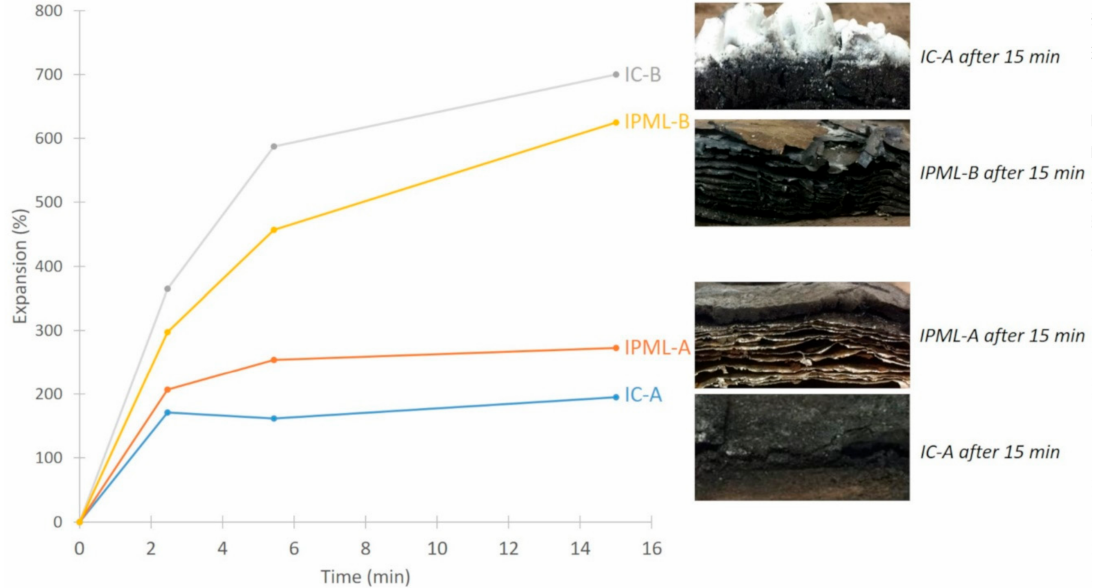
Figure 9. Expansion versus time curves for IC-A, IC-B, IPML-A, and IPML-B